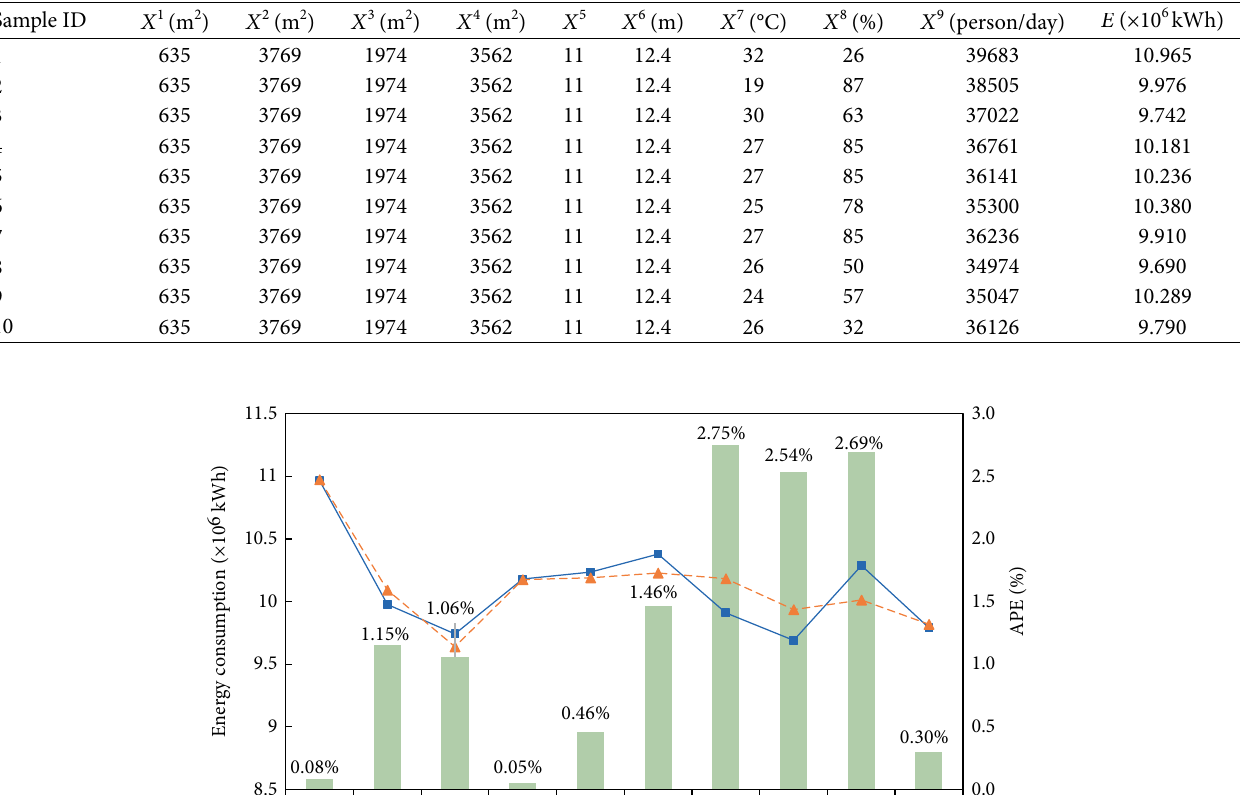
Table 9: Testing dataset.